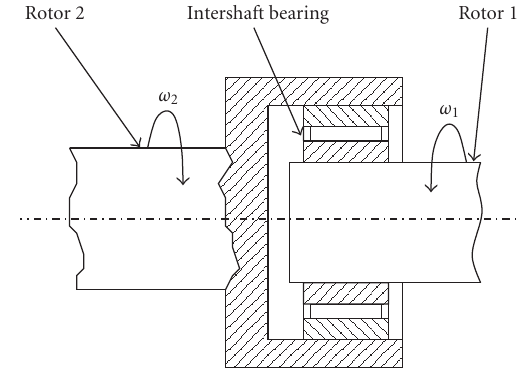
Figure 2: Intershaft bearing